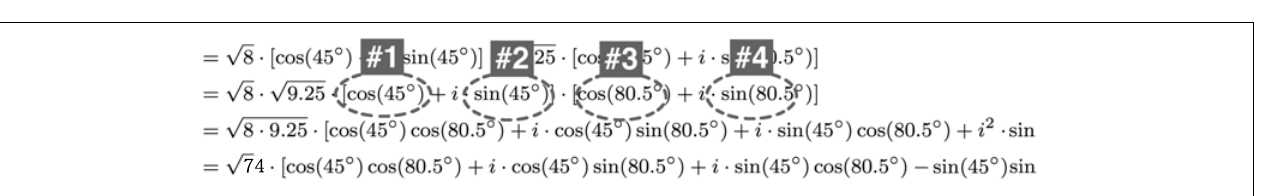
FIGURE 4 | The lengths of the bars depict the individual numbers of self-explanations coded during the three coding procedures. Subjects were ranked with regard to their number of self-explanations that was coded based on verbal, written and non-verbal data.